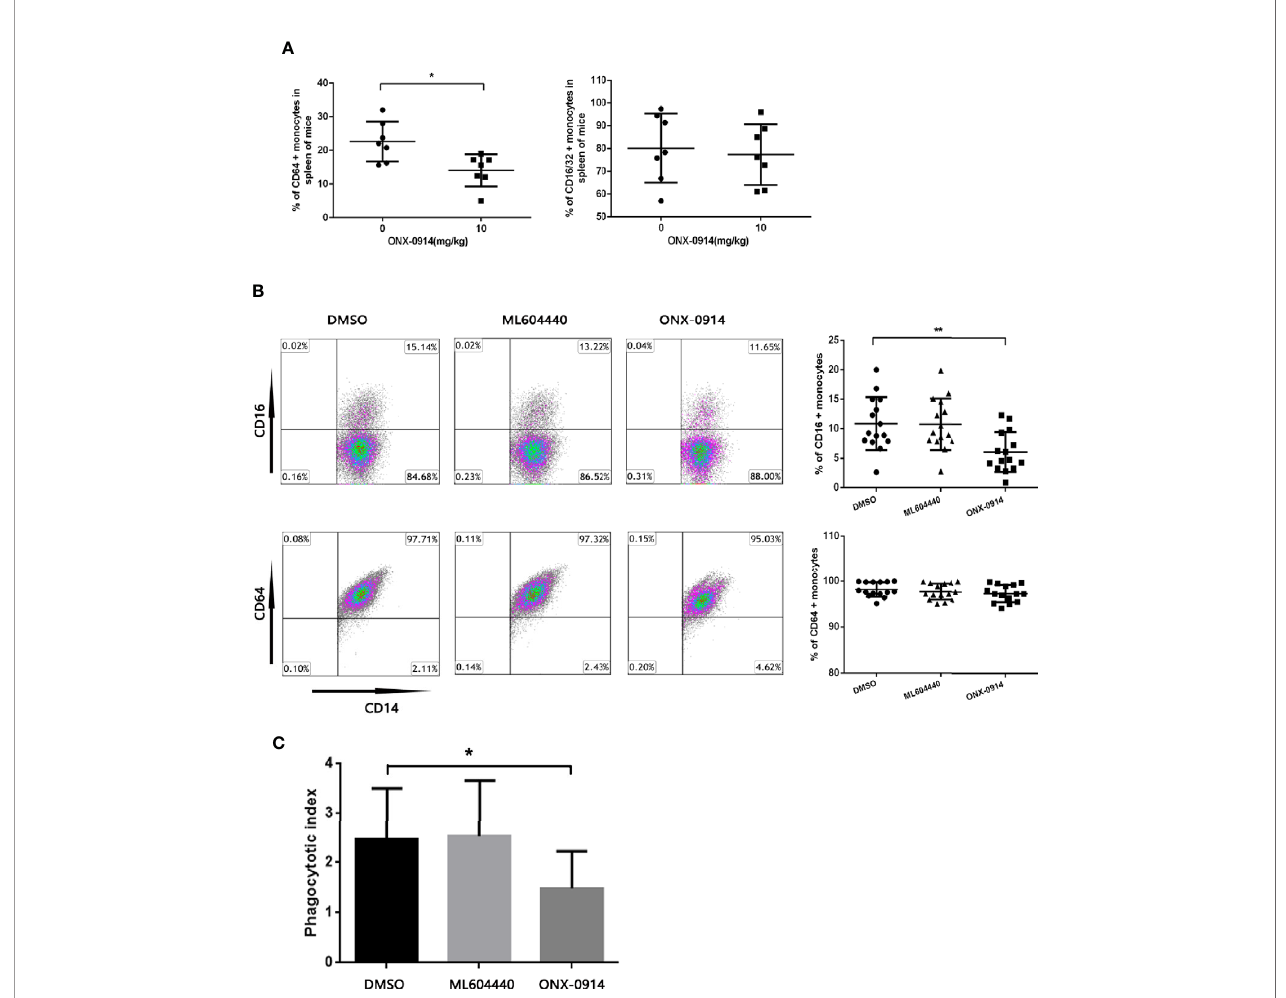
FIGURE 3 | ONX-0914 decreased activating Fc g Rs of monocytes in ITP mice and patients, inhibited the phagocytosis of macrophages in vitro . (A) Flow cytometry analysis of Fc g RI (CD64) or Fc g RIII/Fc g RII (CD16/32) expression on monocytes of passive ITP mice spleen. (B) Flow cytometry analysis of Fc g RI (CD64) or Fc g RIII (CD16) expression on monocyte-derived macrophage of patients. (C) Phagocytic capacity of macrophages from ITP patients after exposure to ML604440 (300 nM) or ONX-0914 (30 Nm) or vehicle. *P < 0.05, **P <